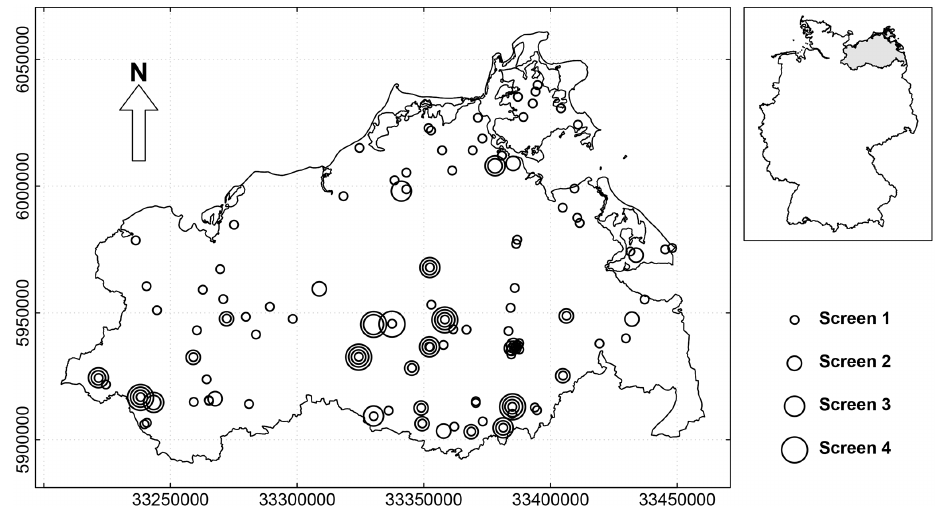
Figure 1. Map of the study area and the selection of groundwater observation wells ( N = 141) in the federal state of Mecklenburg- Vorpommern (highlighted by grey shading in the inset map). The administrative borders of Germany and of the federal state of Mecklenburg- Vorpommern were obtained from GADM (2017).